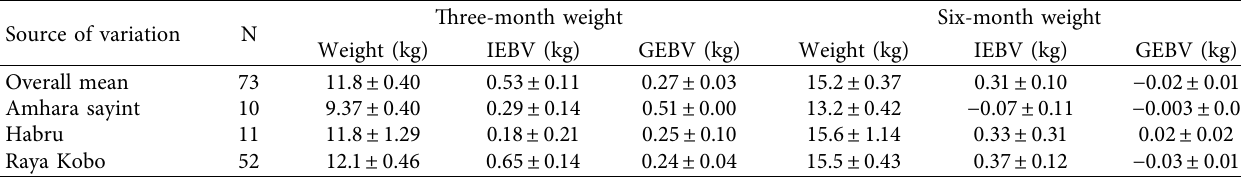
Table 2: Estimated breeding values (LSM ± SE) of disseminated bucks.